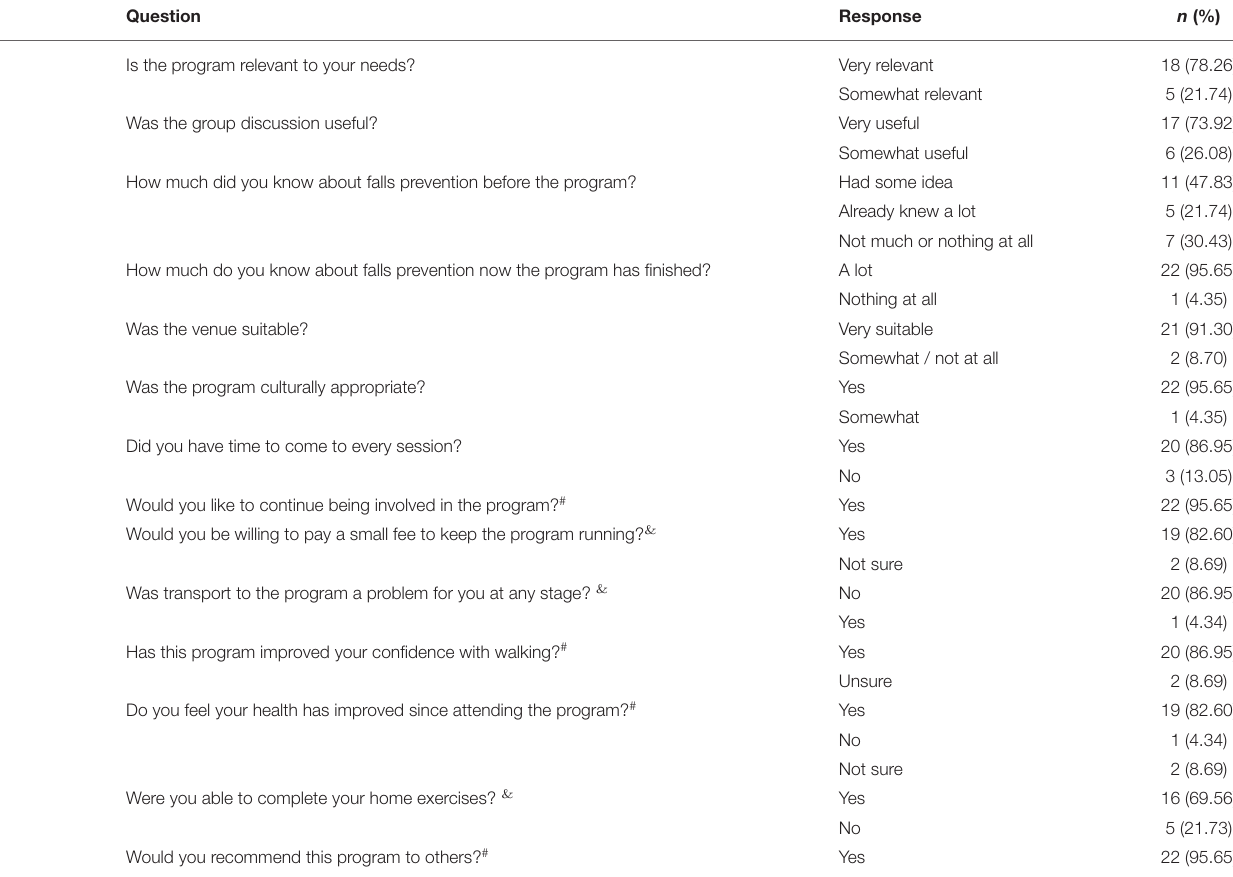
TABLE 3 | Participants’ feedback about the program ( n =